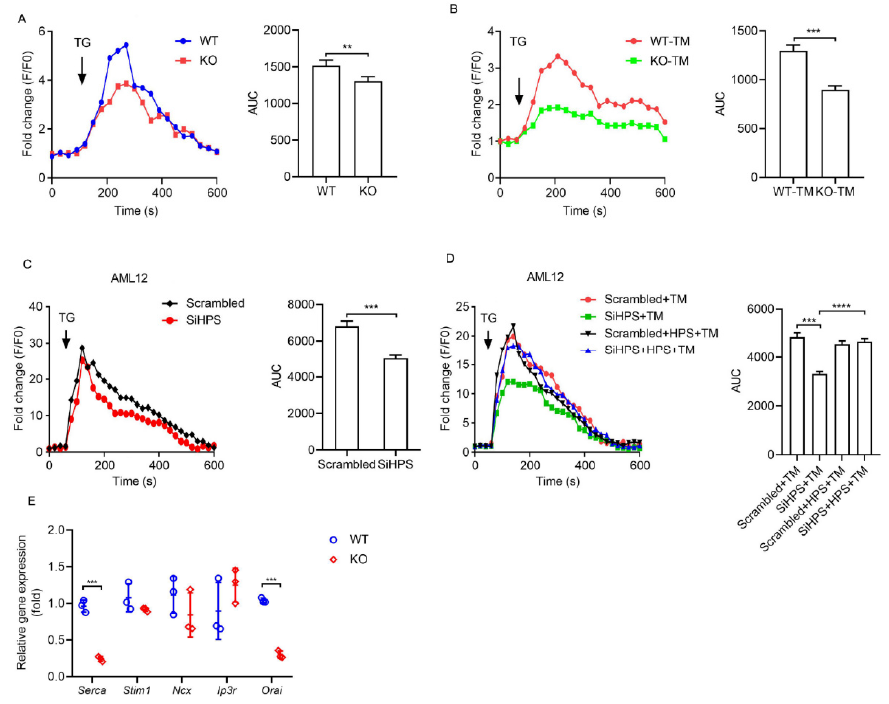
Figure 3. HPS inhibits ER stress-induced ER calcium loss in hepatocytes. ( A ) ER calcium store depletion by 2 µ M TG treatment in WT or HPS-KO primary hepatocytes. ( B ) WT or HPS-KO